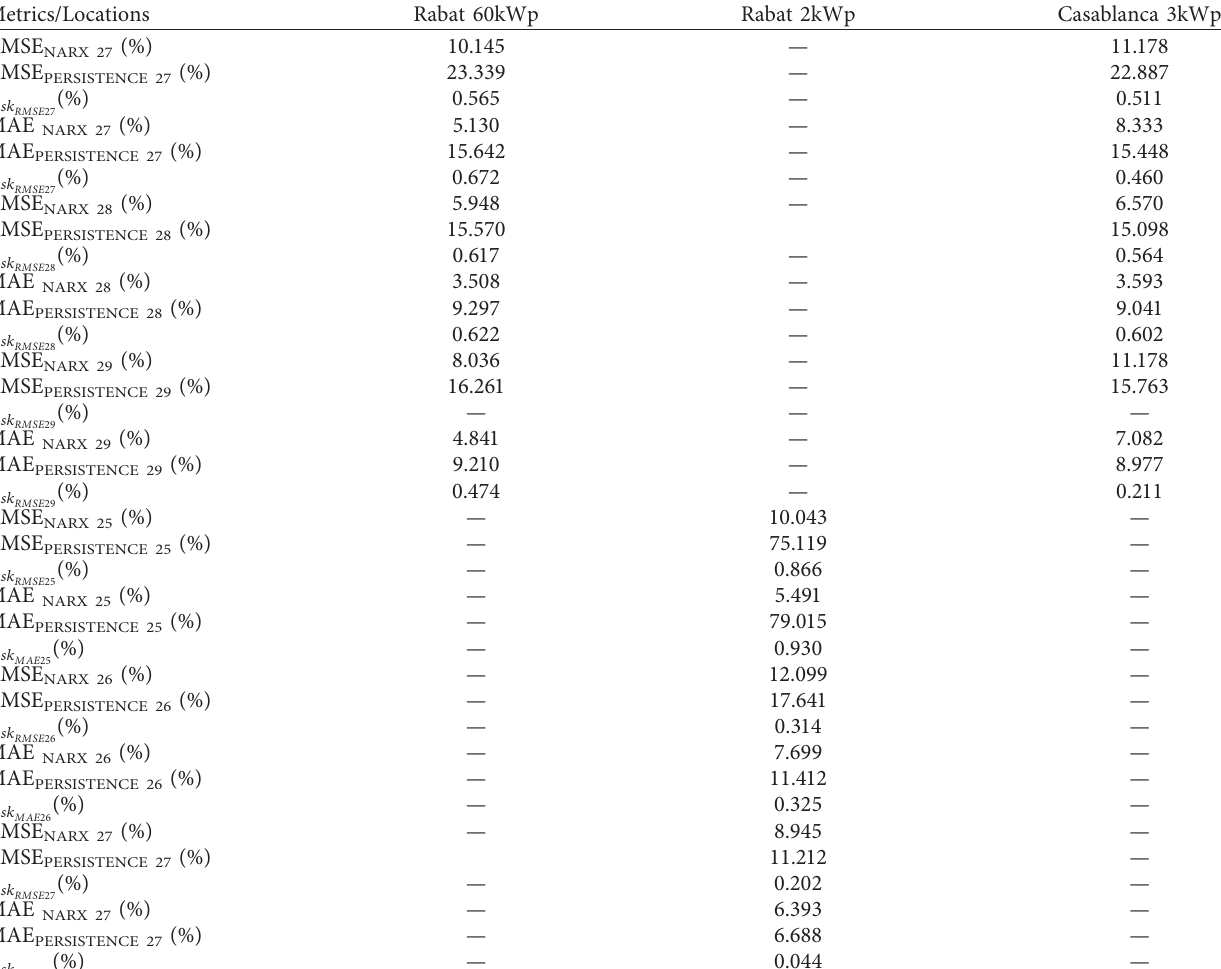
Table 6: Summary of accuracy assessment of NARX neural network forecasting model for each location.